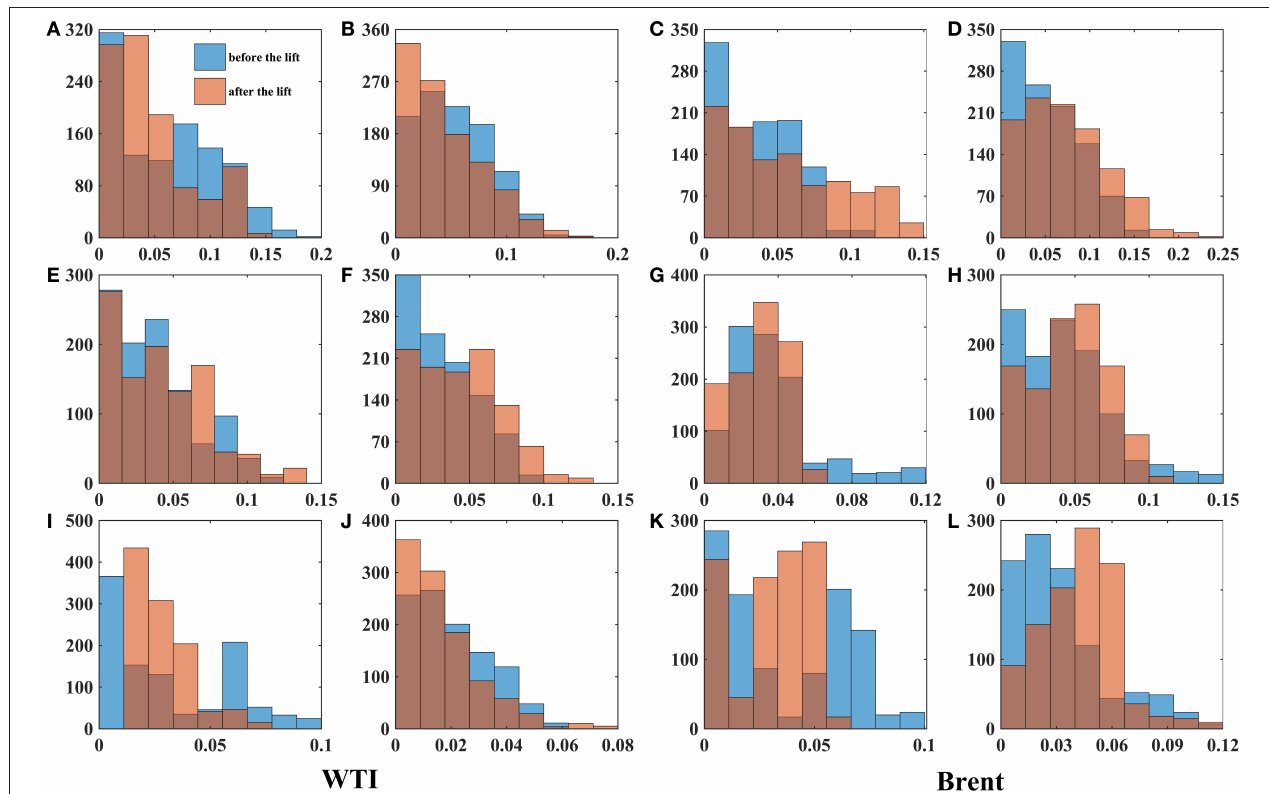
FIGURE 4 | Histograms of δ H . The first and second columns correspond to results of WTI via CDMA and DFA respectively. The third and fourth columns correspond to the results of Brent via CDMA and DFA respectively. (A–D) Corresponds to a rolling window size of 1 year. (E–H) 2 years rolling window. (I–L) 4 years rolling windows.